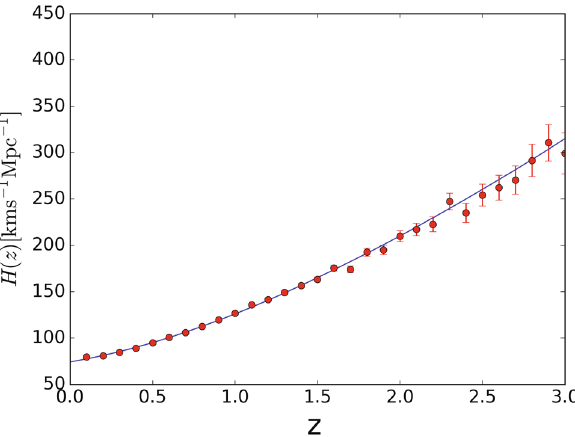
Fig. 8 Mockdatafor3-year-observation.Thebluecurvedenotes H ( z ) value under Λ CDM, while the dots with error bars represent simulation data